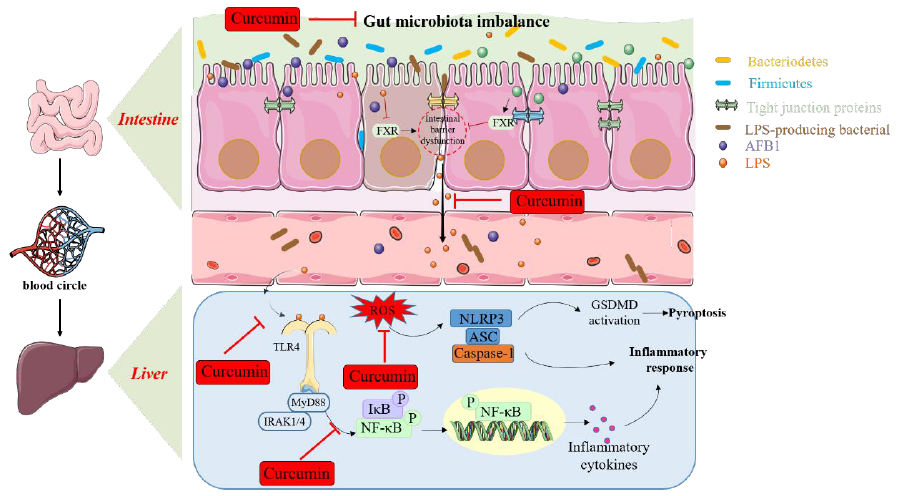
Figure 3. The regulated effects of curcumin on AFB1-induced inflammatory response via modula- tion of gut microbiota and the inhibition of NF- κB, TLR4, and NRLP3